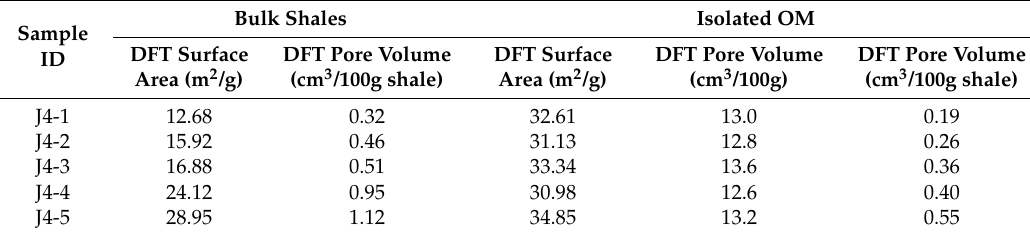
Figure 2. Comparison of low-pressure CO 2 adsorption isotherms of ( a ) isolated OM samples and ( b ) bulk shale samples. Table 2. Pore structure parameters of isolated OM and shale from low-pressure CO 2 adsorption data.